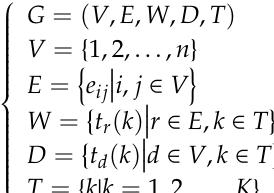
Table 1. Dynamic travel time of each road section.